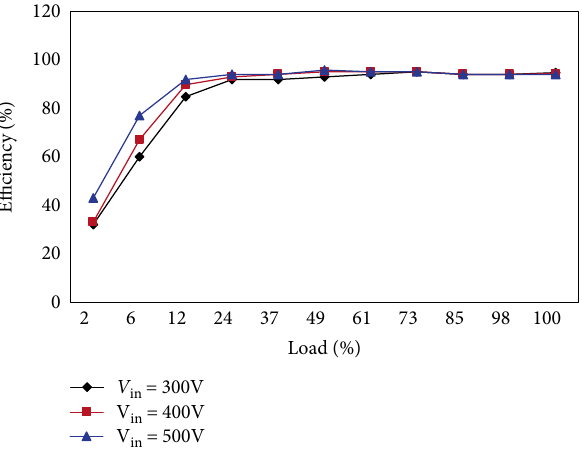
Figure 19: Relationship between load and efficiency at different input